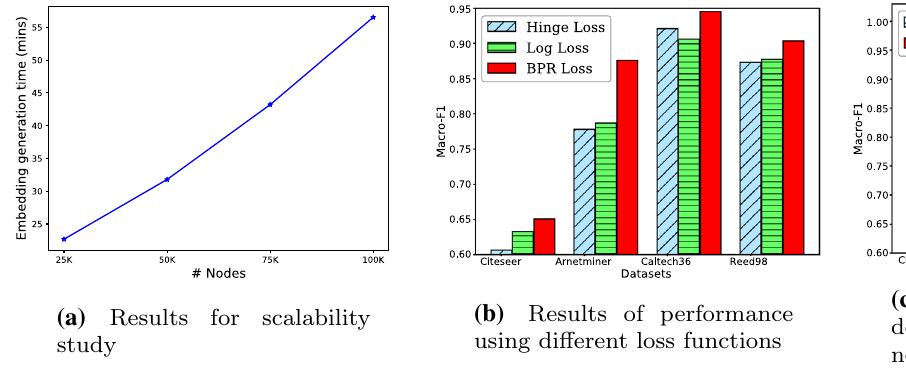
(a) The pooling strategy comparison for the task of node classification Fig. 6 Study effects of pooling strategy and # training triples